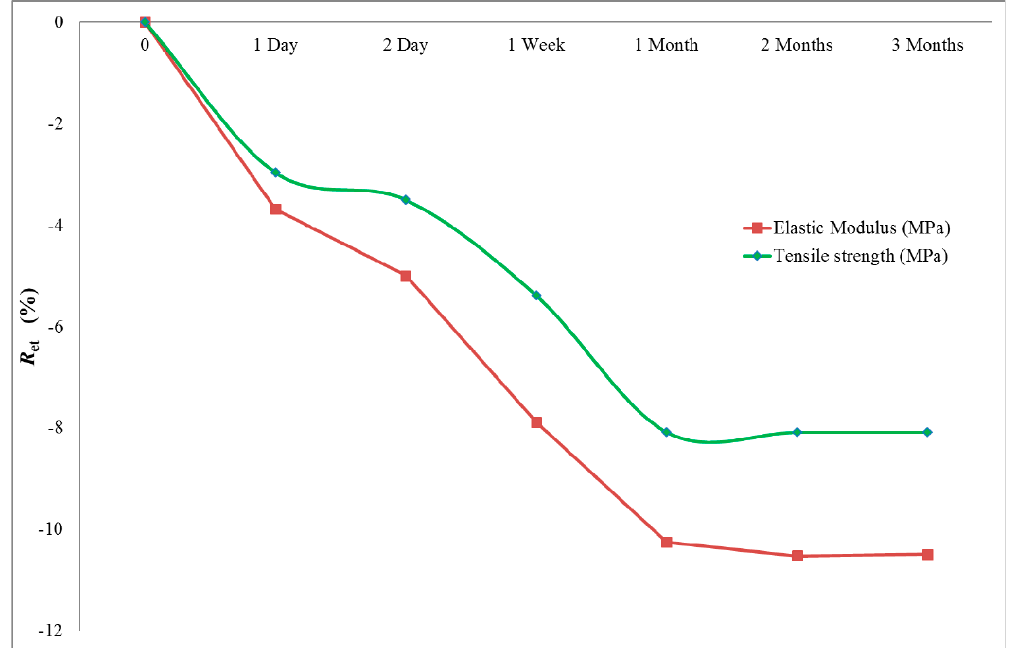
Figure 16. Tensile capacity retention (R et ).